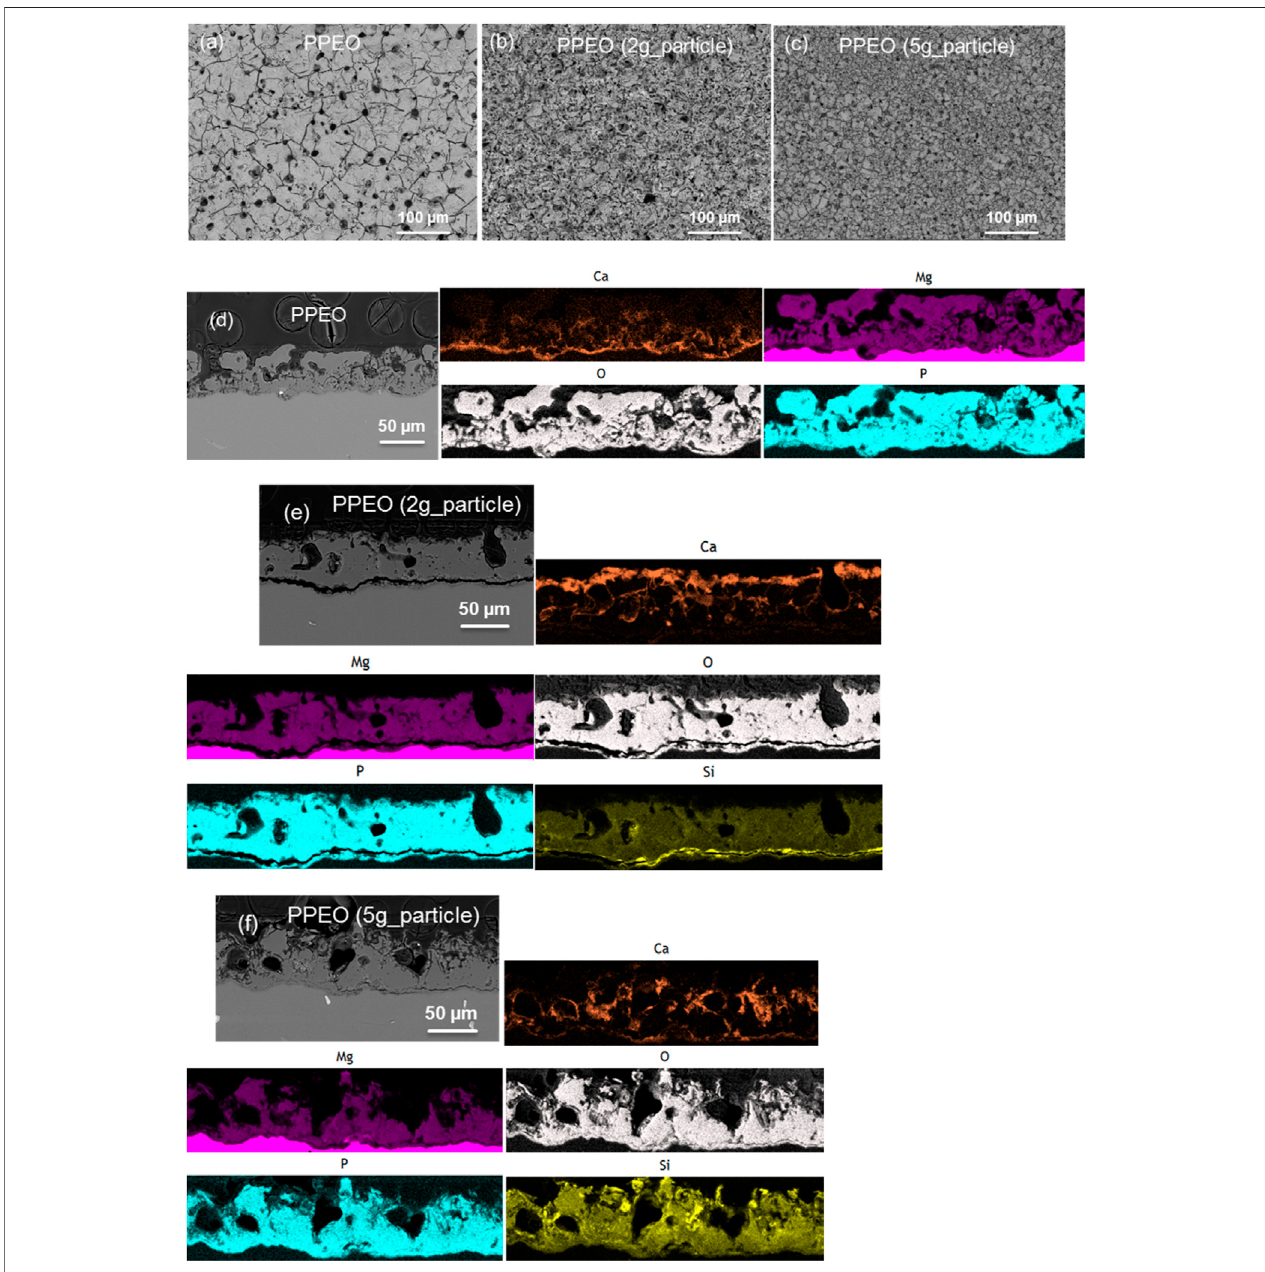
FIGURE3| Surfaceand crosssection morphology ofthe PEO coatings after3-dayscorrosion test. (A) and (D) PPEO, (B) and (E) PPEO (2 g_particle), (C) and (F) PPEO (5 g_particle).